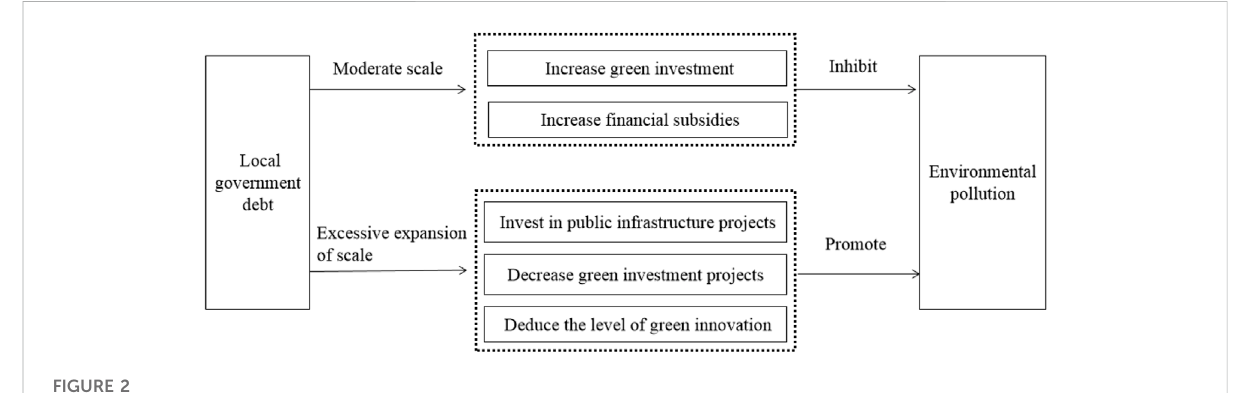
FIGURE 2 Mechanism analysis